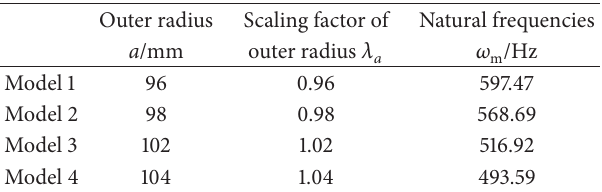
Table 3: Natural frequencies of the 1st mode (2, 1) as a result of the distorted outer radius.